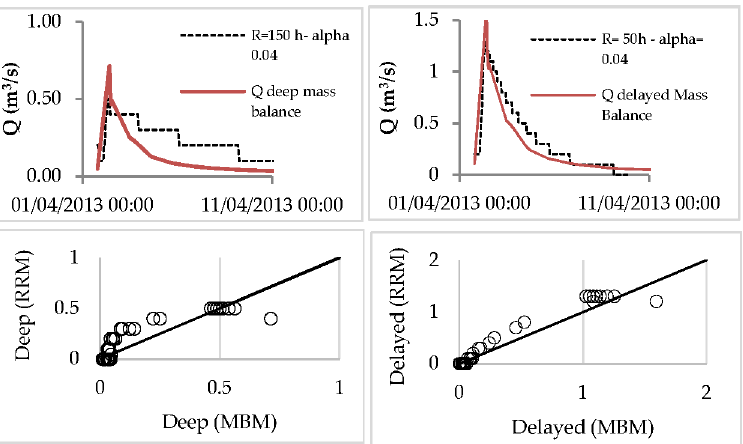
Figure 5. Comparison between the fast and the delayed return flow derived from the mass balance model (MBM) and the rainfall–runoff model